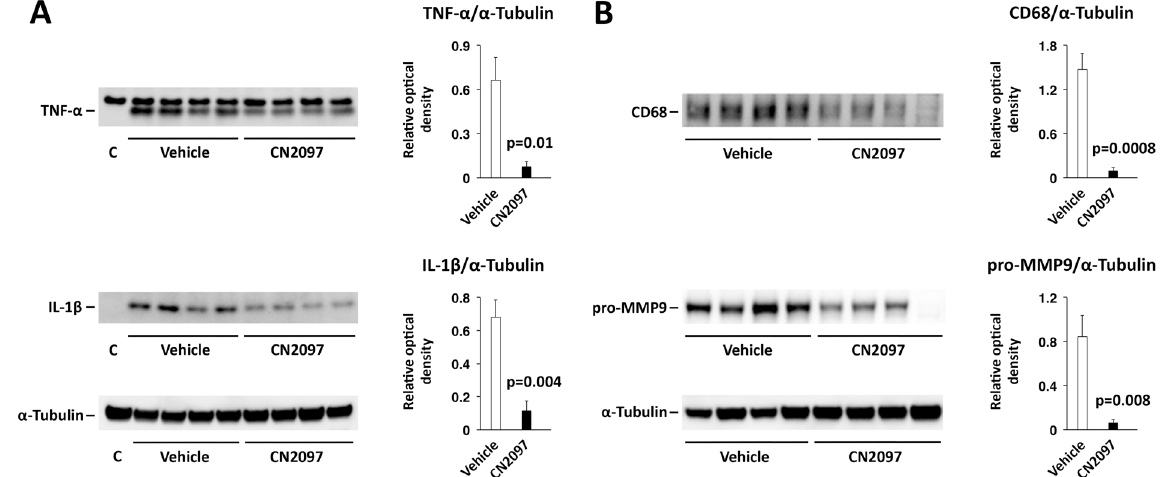
Figure 1. Therapeutic efficacy of CN2097 in reducing post-traumatic neuroinflammation in the injured cerebral cortex. Western blot analysis was performed on cortical samples following CCI. Rats were injected i.p. with CN2097 (10 mg/kg) or vehicle (0.9% NaCl) at 1 and 2 h post-TBI (n = 4 rats/group). Cortical samples were collected at 4 h ( A ) or 24 h ( B ) after TBI. ( A ) CN2097 significantly lowered the post-traumatic production of TNF- α and IL-1 β at 4 h post-TBI. The fully processed, biologically active forms of these proinflammatory cytokines are shown. C: contralateral, uninjured cortex. ( B ) CN2097 inhibited the post-traumatic influx of monocytes to the injured cortex, as assessed by the level of expression of CD68, and reduced the synthesis of MMP9 (pro-MMP9 is shown) at 24 h post-TBI. The expression of CD68 and pro-MMP9 was undetectable in the contralateral cortex. Data represent mean ± SEM. The images shown are cropped. The full-length original images are shown in Fig.